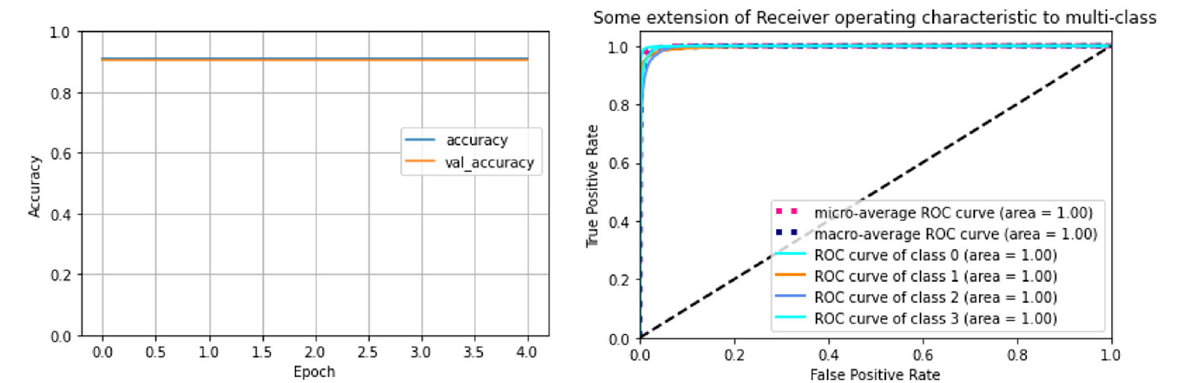
FIGURE9 Performance of RFC model based on the accuracy and true and false positive rate. The values were scaled in the range between 0 and 1, with an accuracy of 1 indicating a perfect prediction. The receiver operating characteristic (ROC) curve tends close to 1 over time to express a perfect learning model.